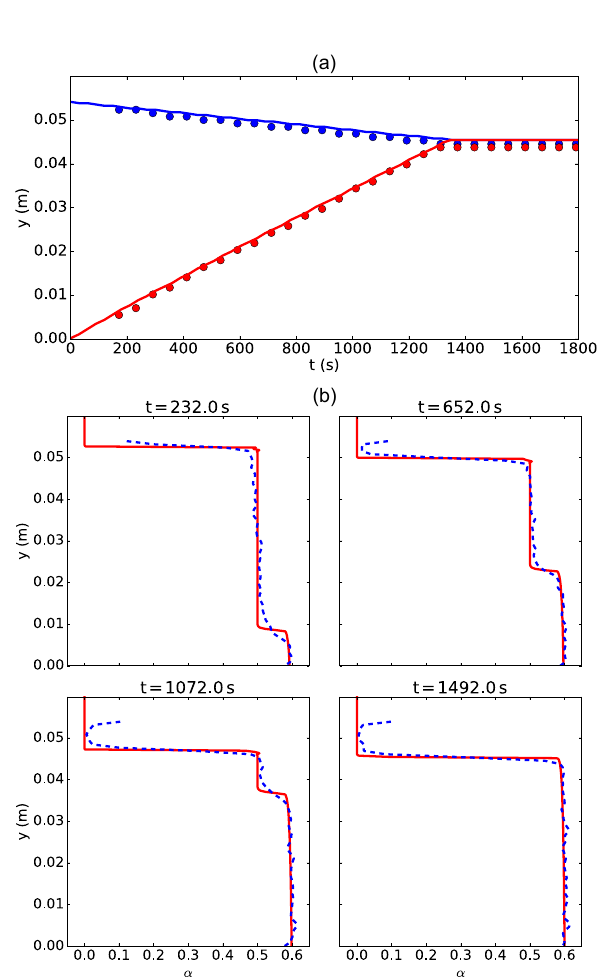
Figure 1. Comparison of two-phase flow model results with exper- iments of Pham Van Bang et al. (2008) (a) settling curves: time evolution of the lower and upper interface positions (circles: ex- periments; lines: model) and (b) profiles of sediment concentration (dashed blue lines: experiment; solid red lines: